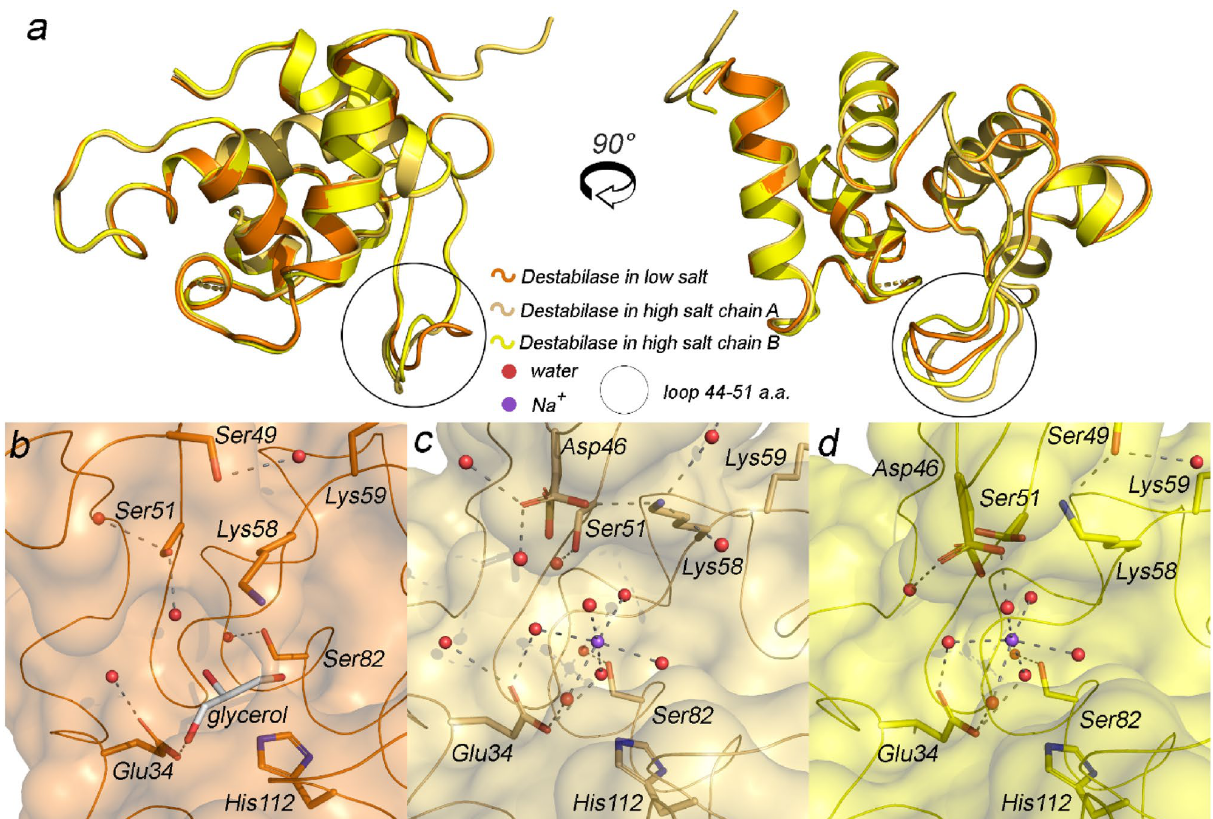
Figure 4. High and low salt destabilase structures. ( a ) Overall structure superposition of all destabilase structures; ( b ) front view of the catalytic cleft in the low salt destabilase structure; ( c,d ) front view of the catalytic cleft in the high salt destabilase structure in chains A and B, correspondingly; residues, potentially responsible for either muramidase or isopeptidase activity, are shown as sticks; Na + ion and water molecules are shown as spheres. Water molecules and hydrogen bonds are shown only for alternative conformations with presence of sodium. Water coordinated Na + ion occupies the cleft between catalytic dyad Glu34/Asp46 and fixates the flexible loop 44–51 in the closed conformation preventing a substrate from approaching the active